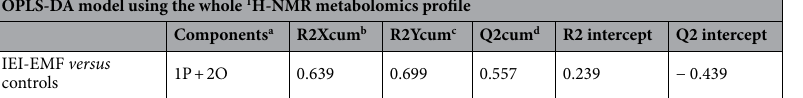
OPLS-DA model using the whole 1 H-NMR metabolomics